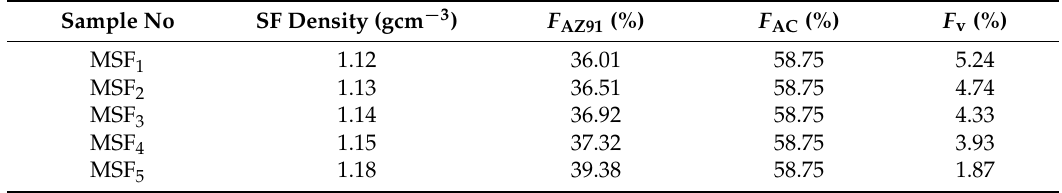
Table 1. The physical properties of the AZ91–AC syntactic